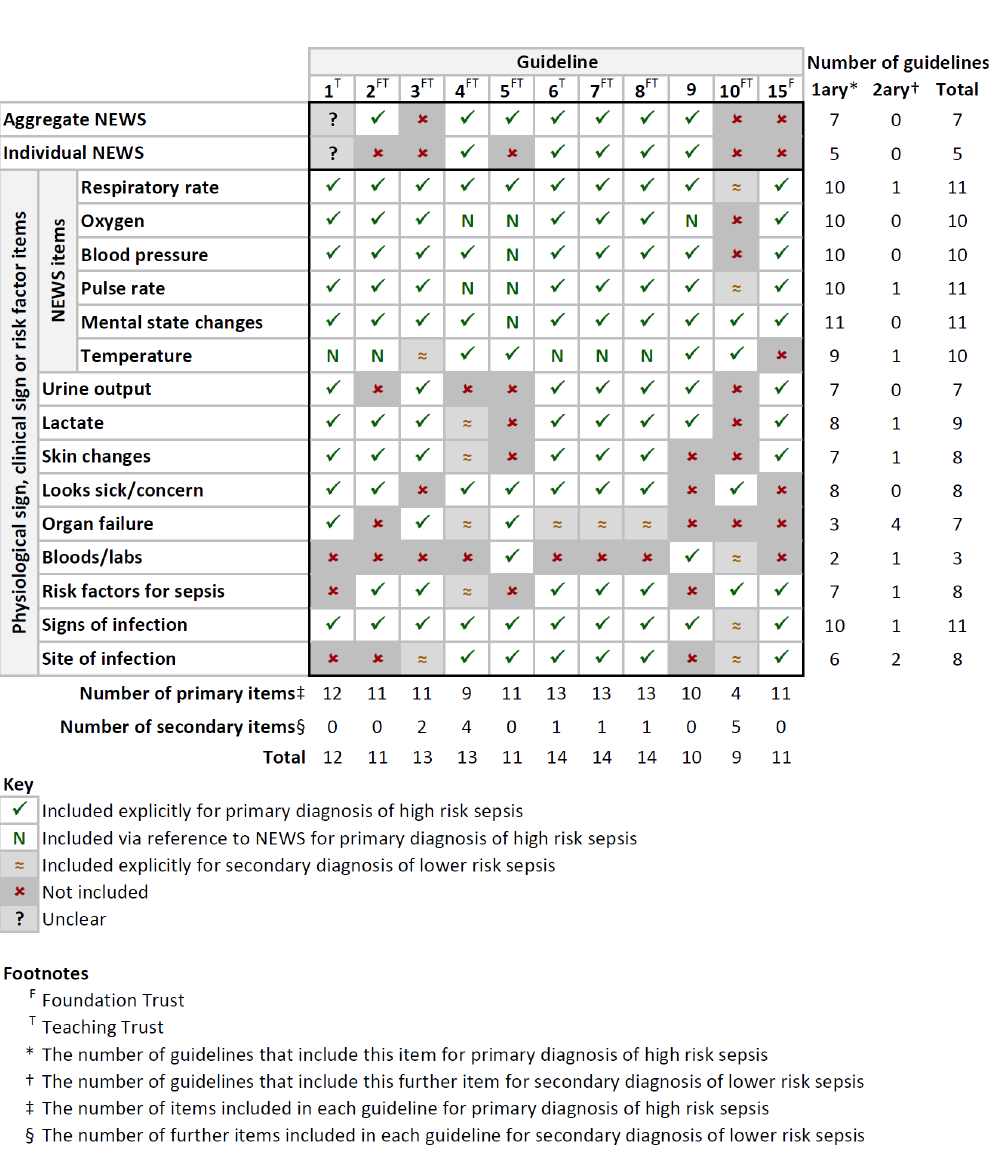
Figure 1. Reference results: A summary of NEWS scores, physiological signs, clinical signs, and risk factors included in each guideline for the identification of sepsis. Trusts are ordered from left to right by descending number of general and acute beds [16].